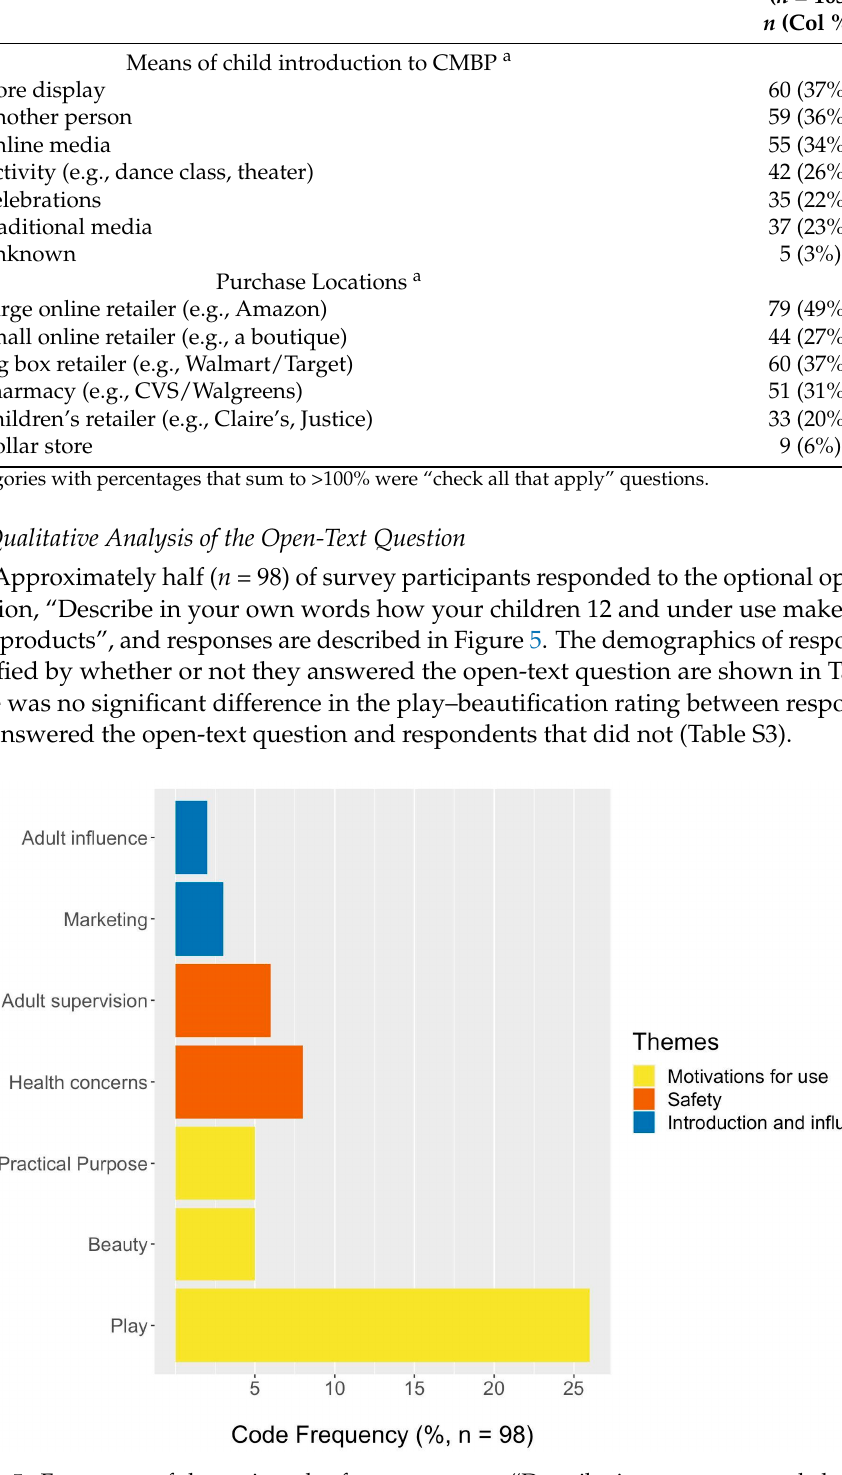
Figure 5. Frequency of thematic codes for responses to “Describe in your own words how your children 12 and under use makeup and body products”. children 12 and under use makeup and body